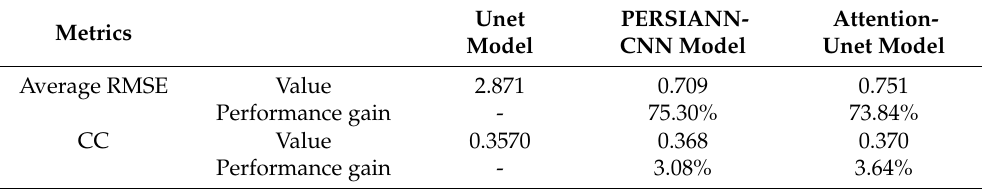
Table 9. Summary of precipitation estimation performance over the verification